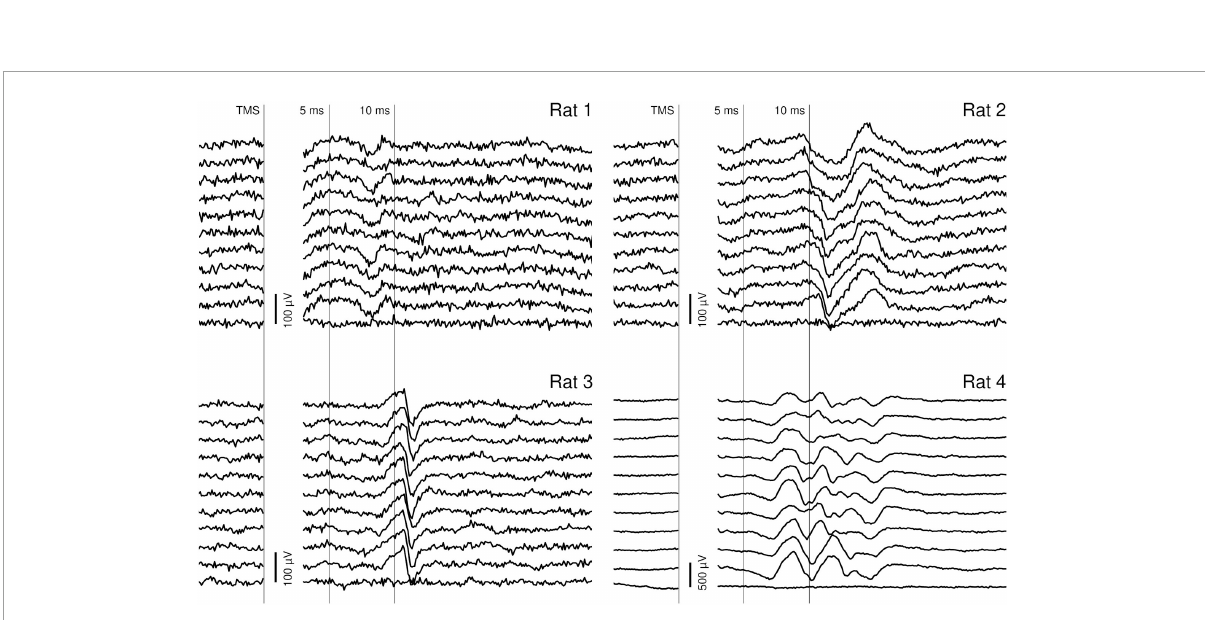
FIGURE4 Stability of individual responses. Ten consecutive individual responses recorded within one block, with constants stimulation parameters. The traces were recorded from the right forelimb (rat 1) or from the left forelimb (rats 2–4). In each rat, the stimulation caused a highly reproducible EMG response with an onset latency of 7–10 ms and an offset latency of 10–15 ms. The stimulation artifact has been